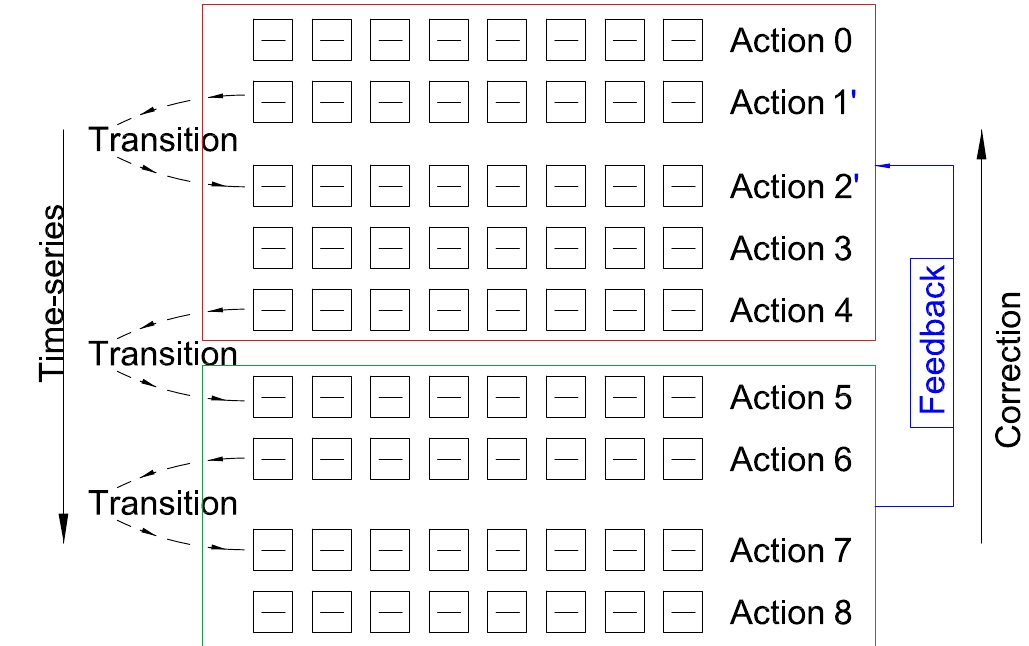
Figure 3. Error correction framework of time-series based sensor